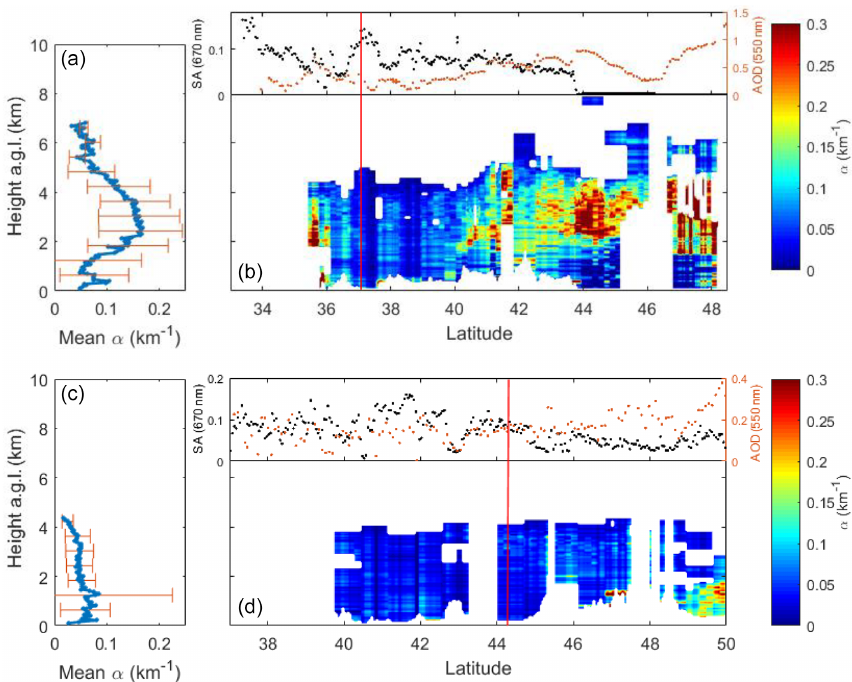
Figure 3. Aerosol extinction at 532m as provided by CALIPSO and constrained by MODIS AOD on 7 April 2011 (a, b) and 4 July 2012 (c, d) as well as the corresponding averaged profiles for the considered part of the track (a, c) . The error bars are the standard deviation. The red vertical lines represent the locations of the Granada (a, b) and Bucharest (c, d) stations. MODIS AOD 550nm (orange dots) and surface albedo at 670nm (black dots) along the track are also depicted in the top part of the curtain plots.